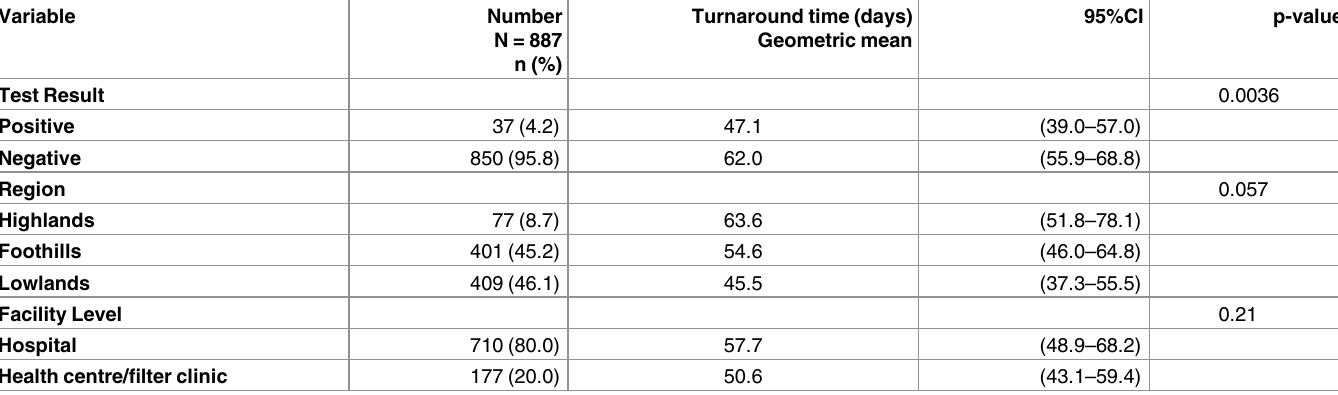
Table 3. Turnaround time for 887 subjects with complete data calculated from a linear mixed model including test result, region and facility level.